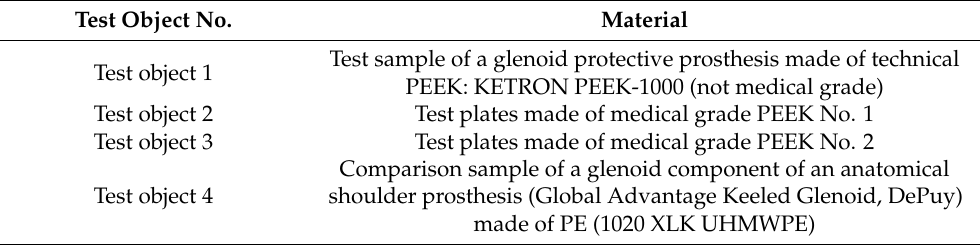
Table 2. Overview of test objects for abrasion measurement. Test Object